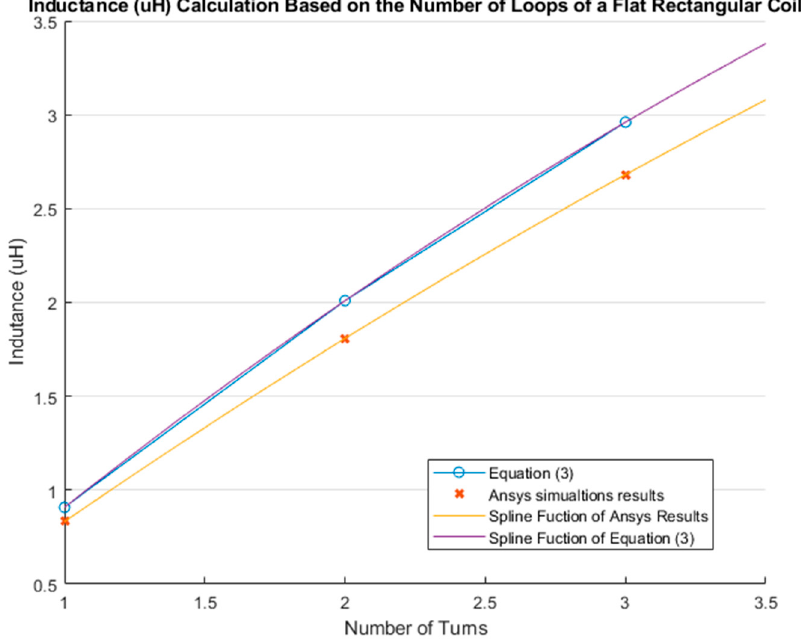
Figure 20. Comparison between the results obtained from Equation (3) and